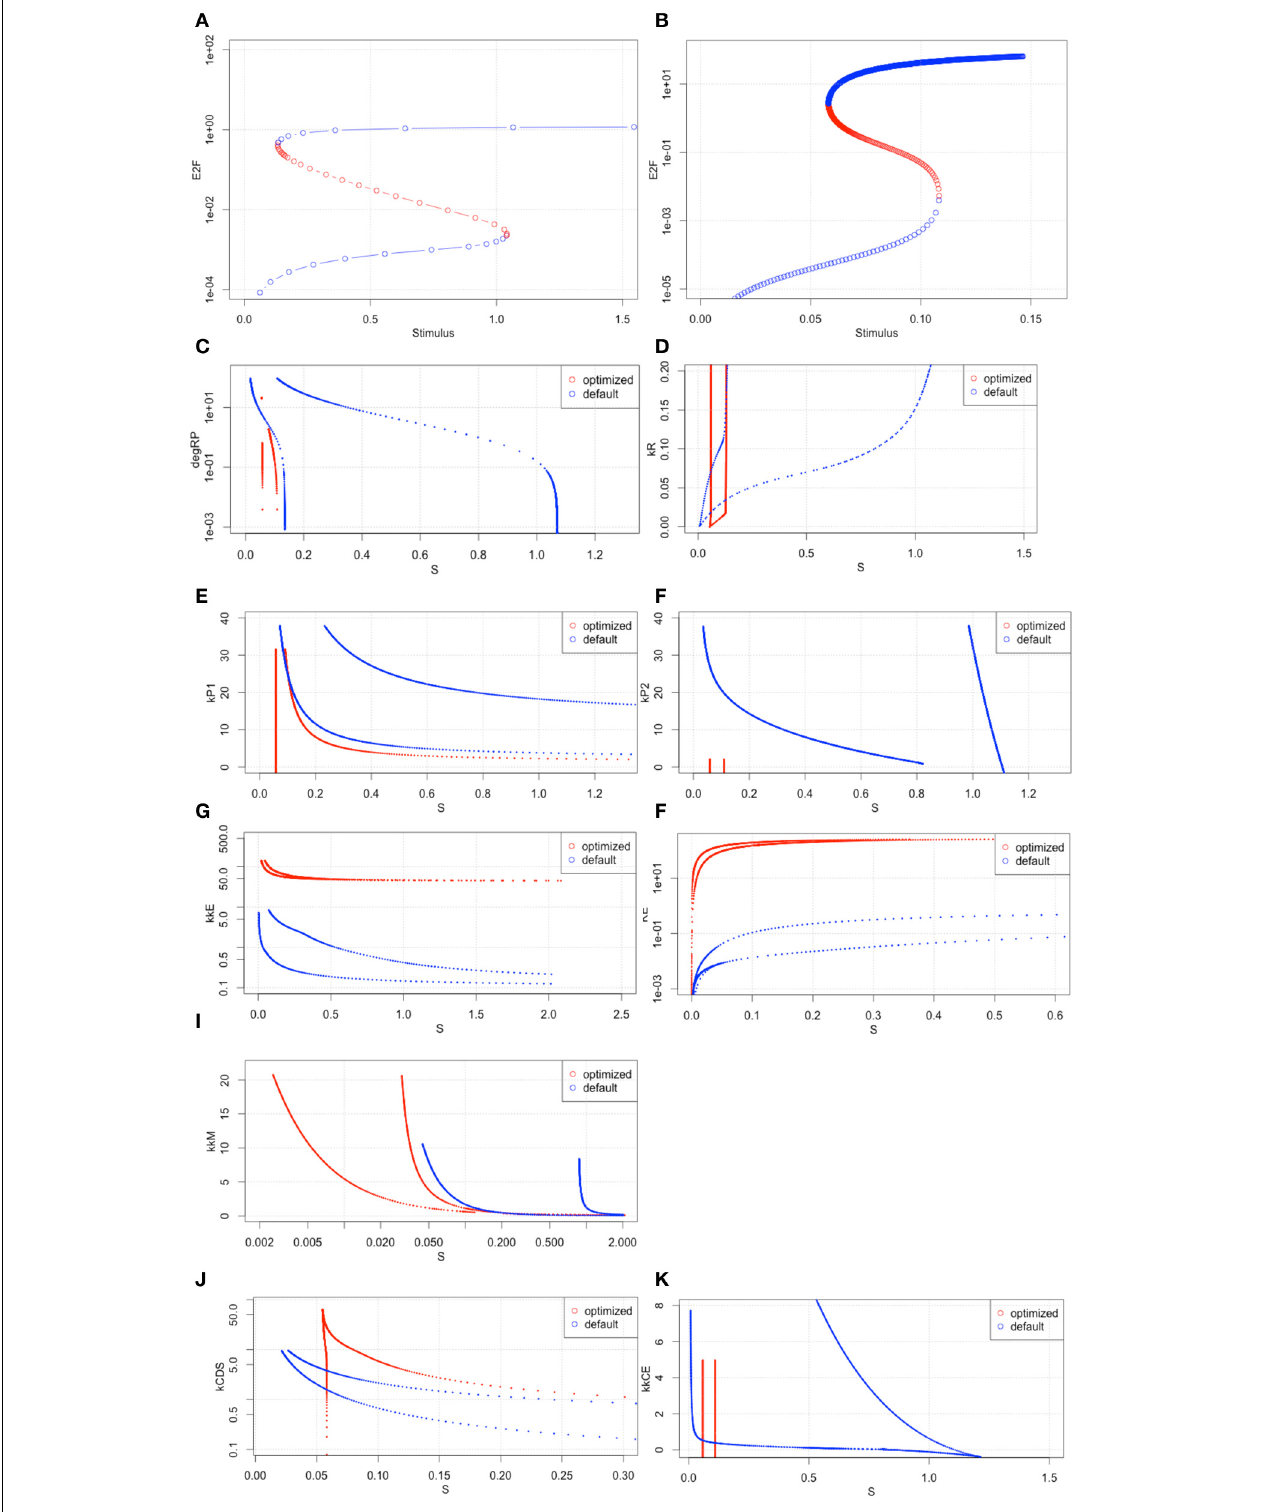
FIGURE 8 | Bifurcation analyses with the 2nd set of optimized parameters. (A,B) the results of bifurcation analysis with the original parameter set and the 2nd optimized set. (C–K) Two parameter space analyses. All x-axes indicate S values. The y-axis of each graph indicates (C) degRP.